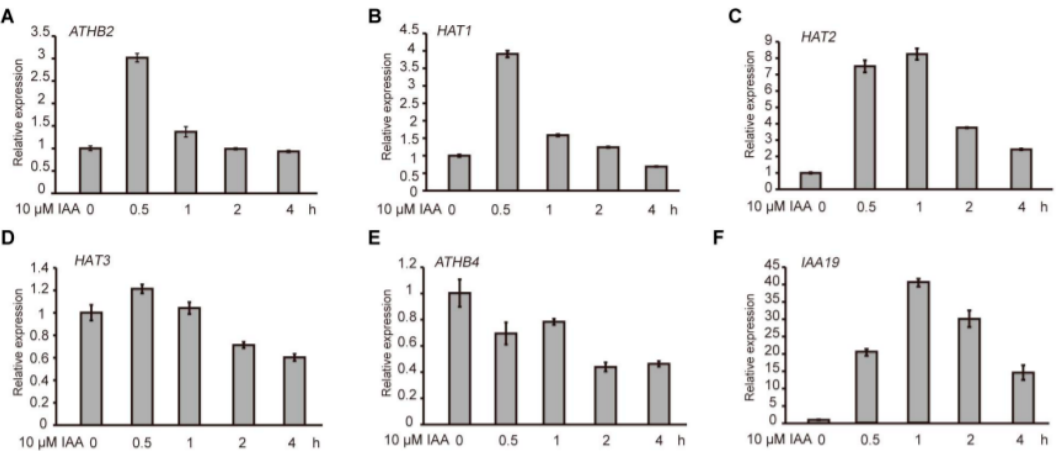
Figure 1. Expression patterns of the ATHB2 subset genes. ( A – F ) Expression analyses of ATHB2, HAT1, HAT2, HAT3, ATHB4 and 1AA19 in response to auxin treatment. The 6 day old wild-type (Col-0) seedlings were treated with 10 μ M IAA for different time points. The ACTIN7 gene was used as an internal reference. The qRT-PCR results were performed for three biological replications and similar results were observed. Representative qRT-PCR results with three technical replicates were shown. Error bars denote ±